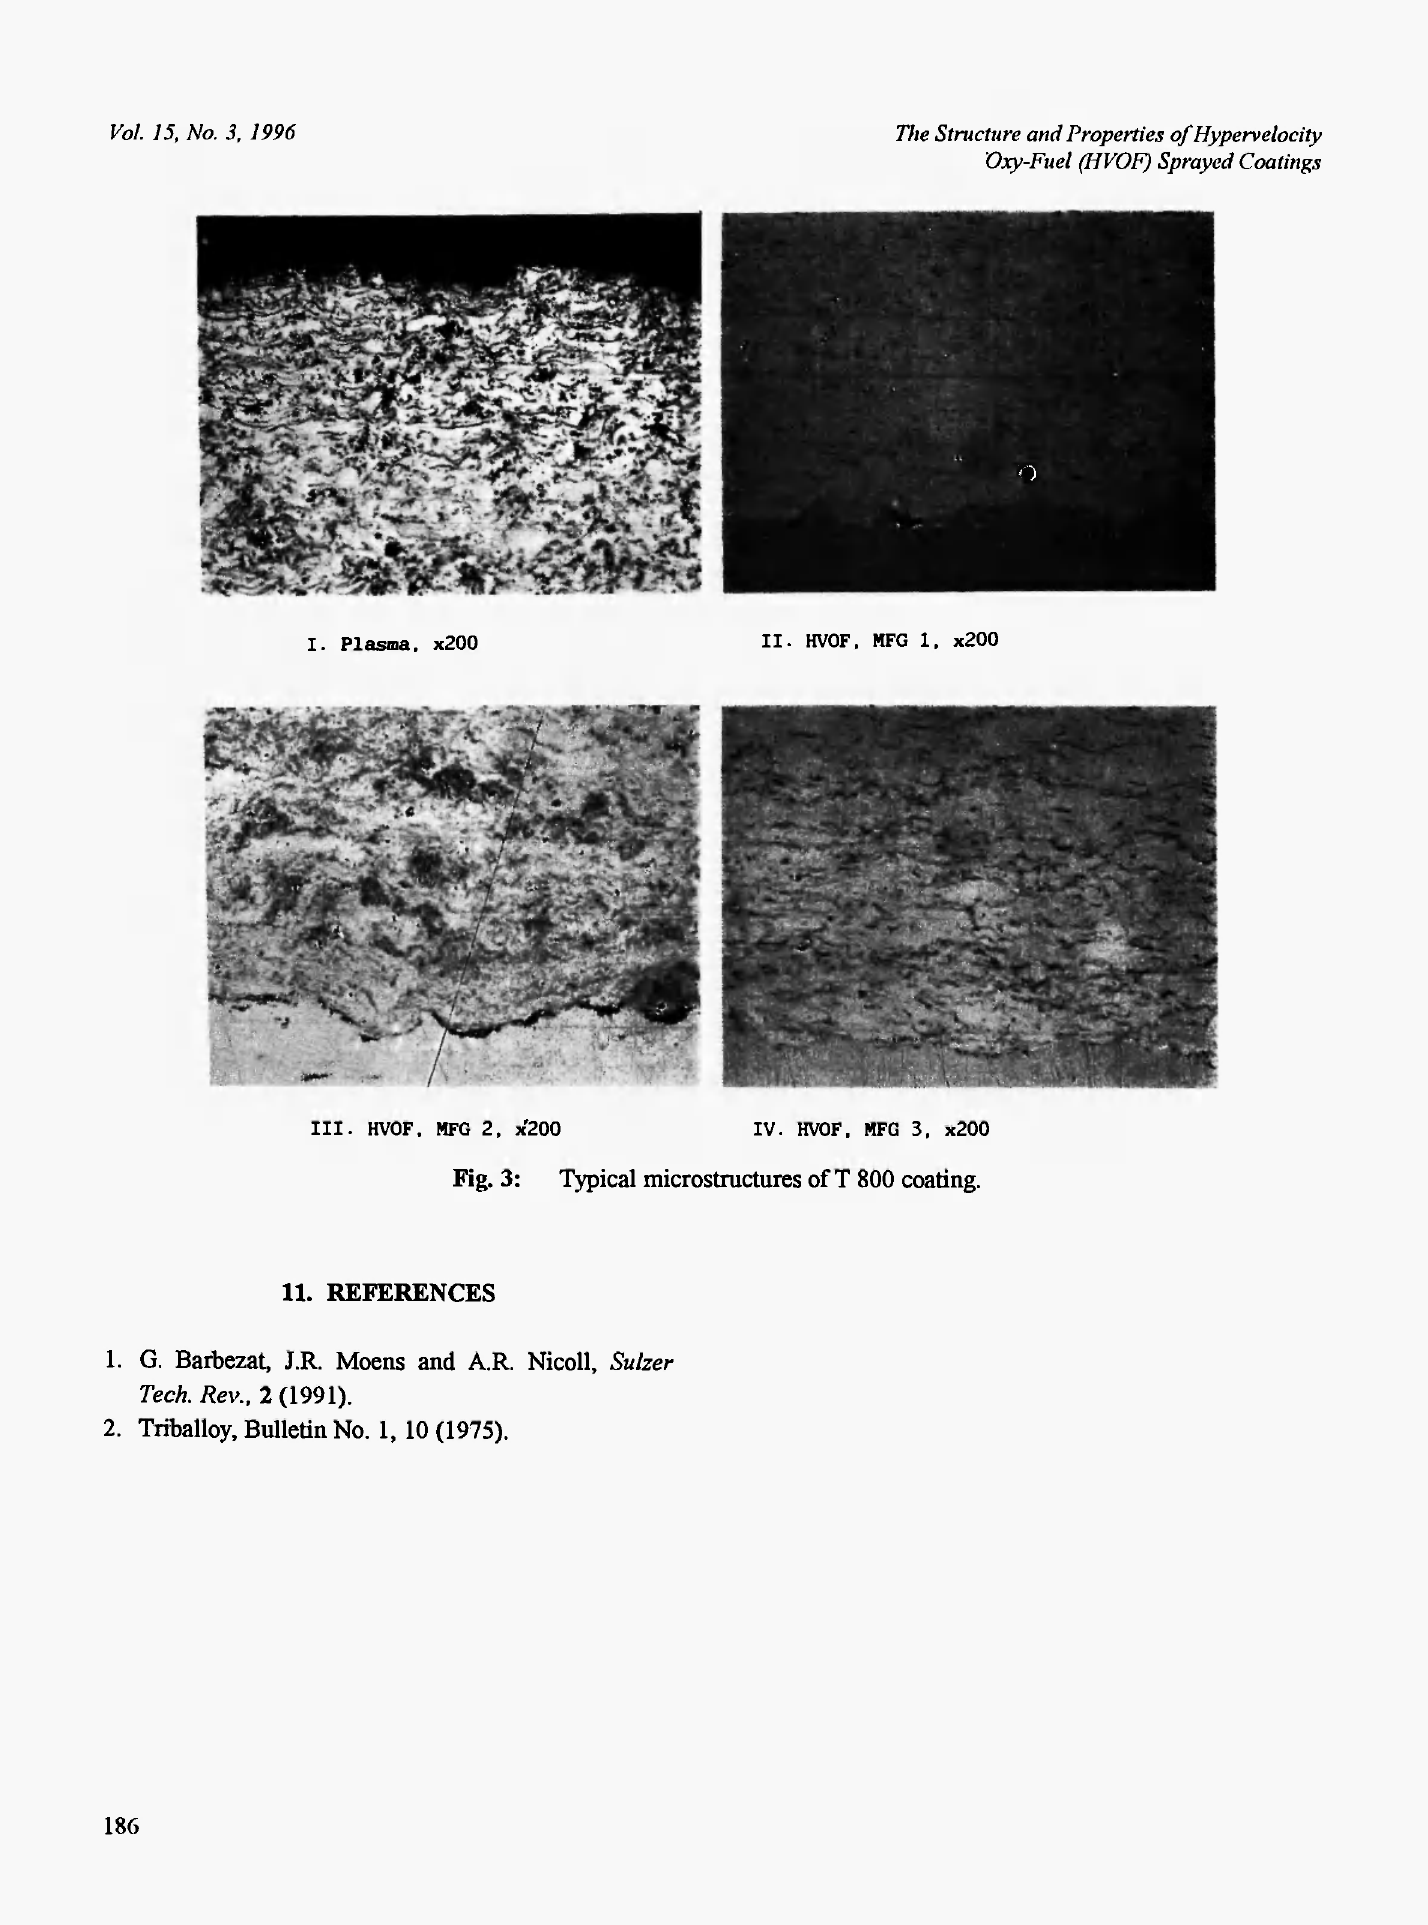
Fig. 3: Typical microstructures of Τ 800